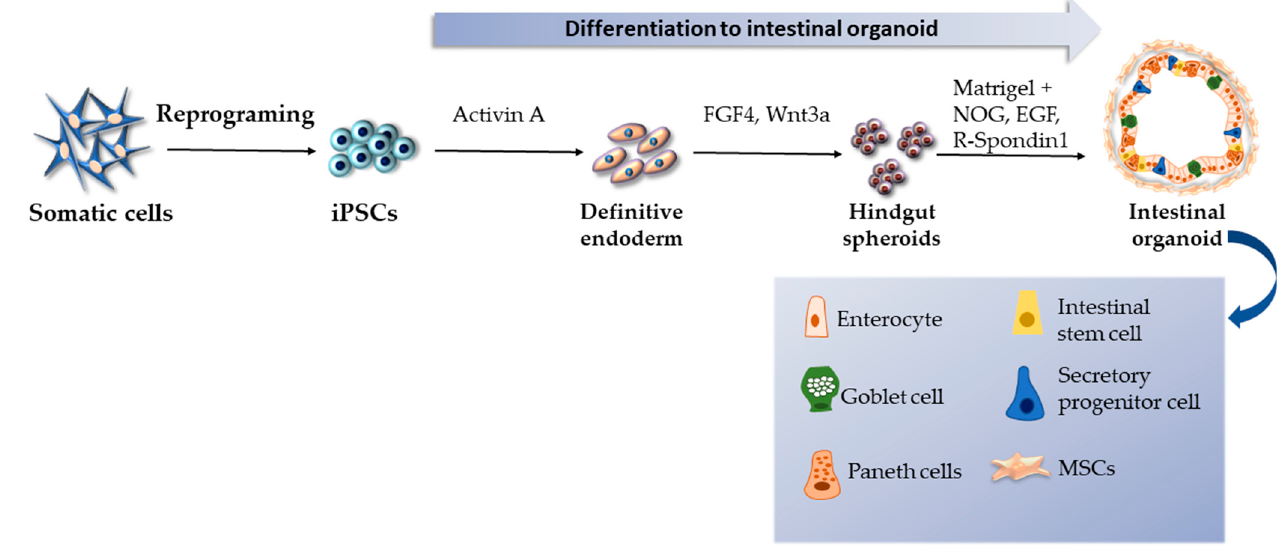
Figure 3. Generation of intestinal organoids according to the protocol by Spence et al. [81].